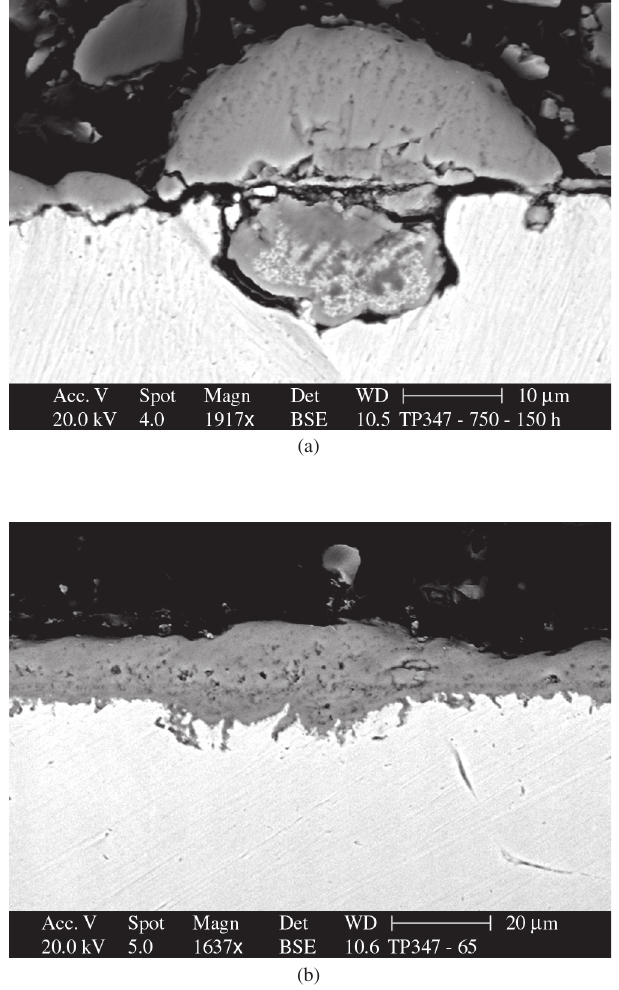
Figure 2. Cross sections of the oxide scales formed on TP347 after oxidation in laboratory air at 750 °C for 120 hours: a) fine-grained; and b) coarse- grained